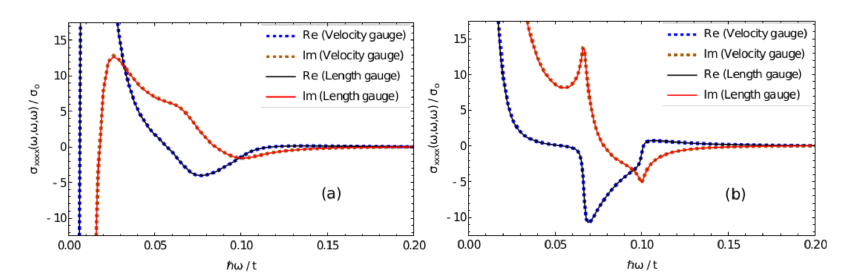
Figure 1. Frequency dependence of the third-order nonlinear conductivity of graphene, normalized to σ µ/ t = 0 . 1, γ/ t = 0 . 011; (b) µ/ t = 0 . 1, 0 at zero temperature. The parameters used here were (a) γ/ t = 0 . 001, for γ and t the scattering and hopping parameters, respectively. The solid curves were obtained from a length gauge approach and the dashed ones from a velocity gauge calculation. Image and caption were taken from